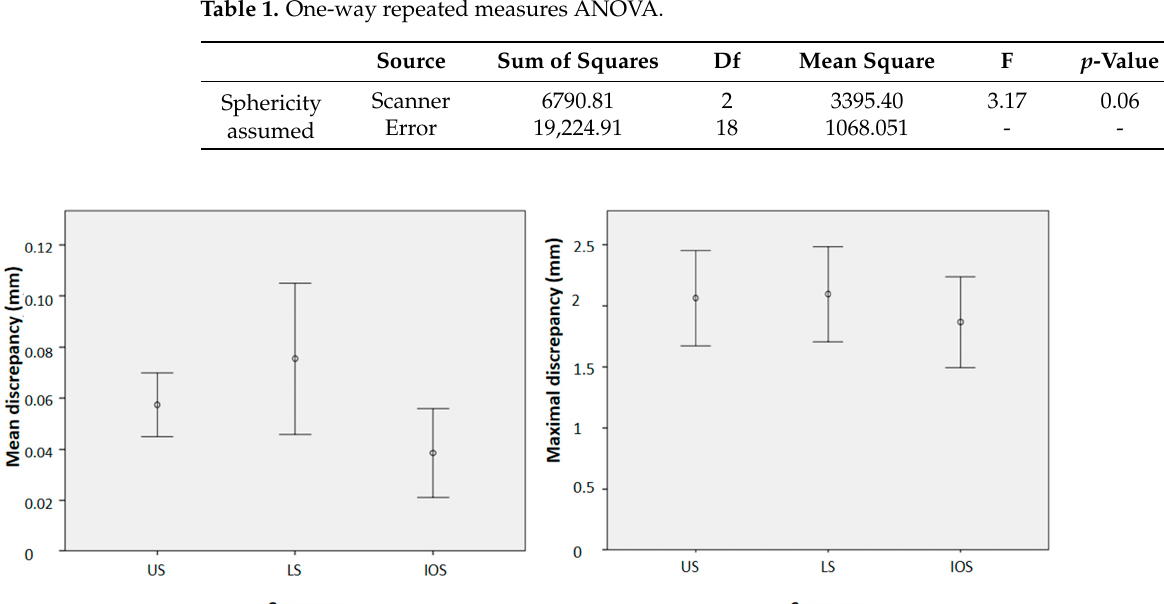
Table 1. One-way repeated measures ANOVA.